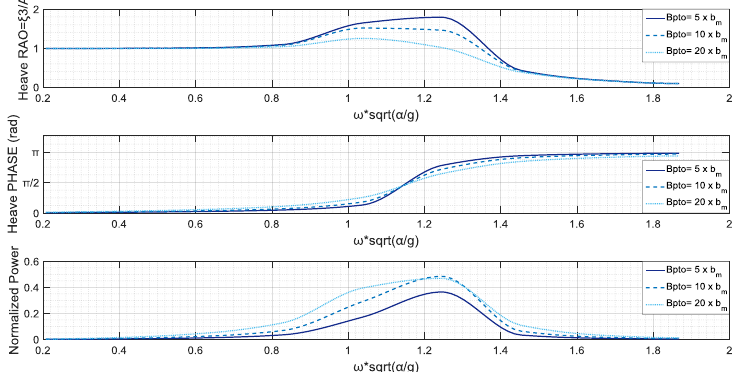
Figure 10. Heave RAO, Phase RAO and Normalized Power Output-Conical WEC.